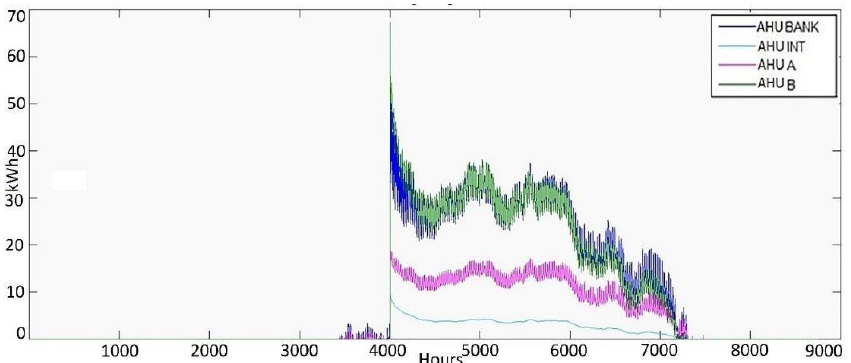
Energies 2022 , 15 , x FOR PEER REVIEW Figure 10. AHU hourly Cooling energy consumptions. Figure 10. AHU hourly Cooling energy consumptions. Figure 10. AHU hourly Cooling energy consumptions.